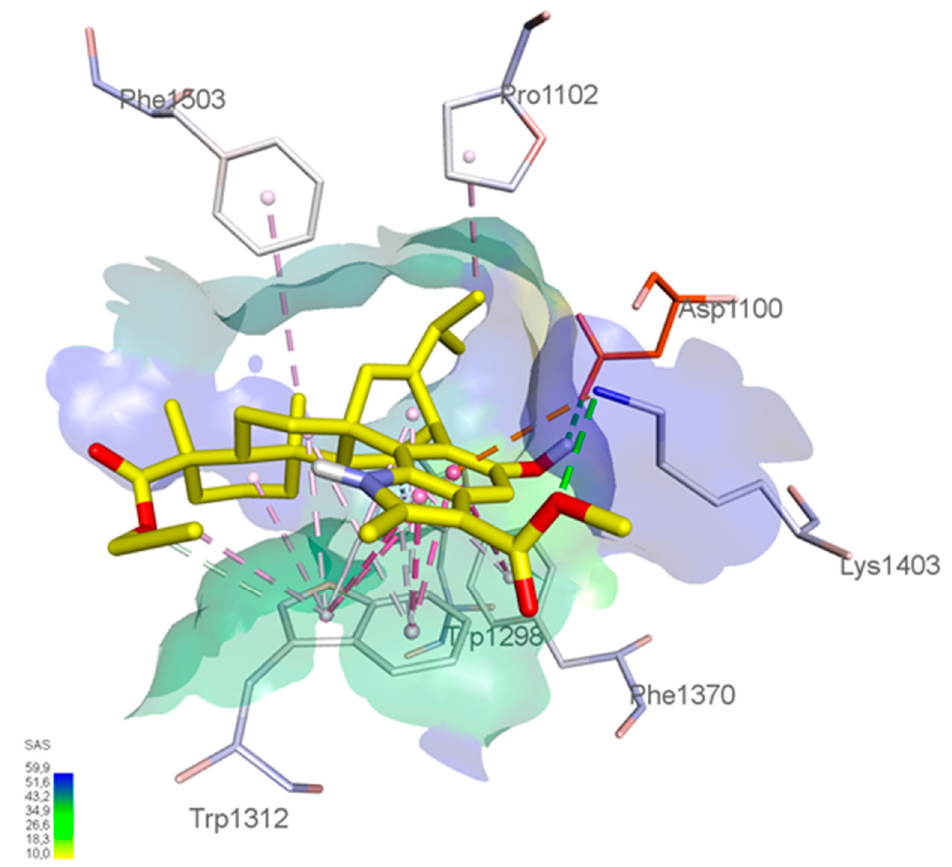
Figure 5. Proposed binding mode of compound 45 to yeast α -glucosidase. The inhibitor is shown in yellow carbons, catalytic Asp1100 is shown in orange carbons. Surface visualized solvent-accessible area. Dashed lines indicate key interactions with enzyme amino acids.